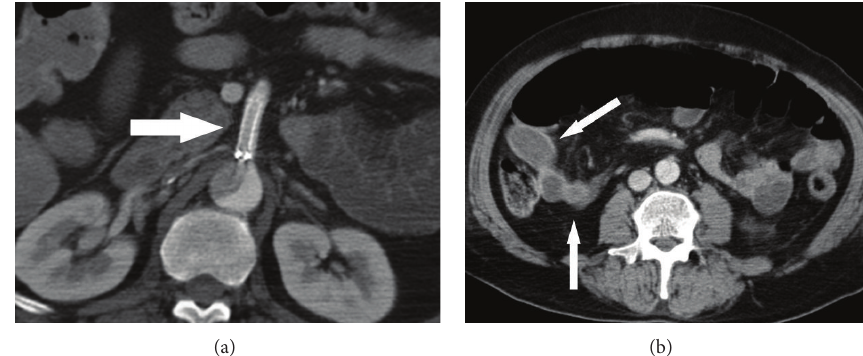
Figure 4: Contrast-enhanced CT shows (a) the patency of the stent placed in the SMA (arrow) and (b) the improvement of enhancement of the small intestine (arrow).